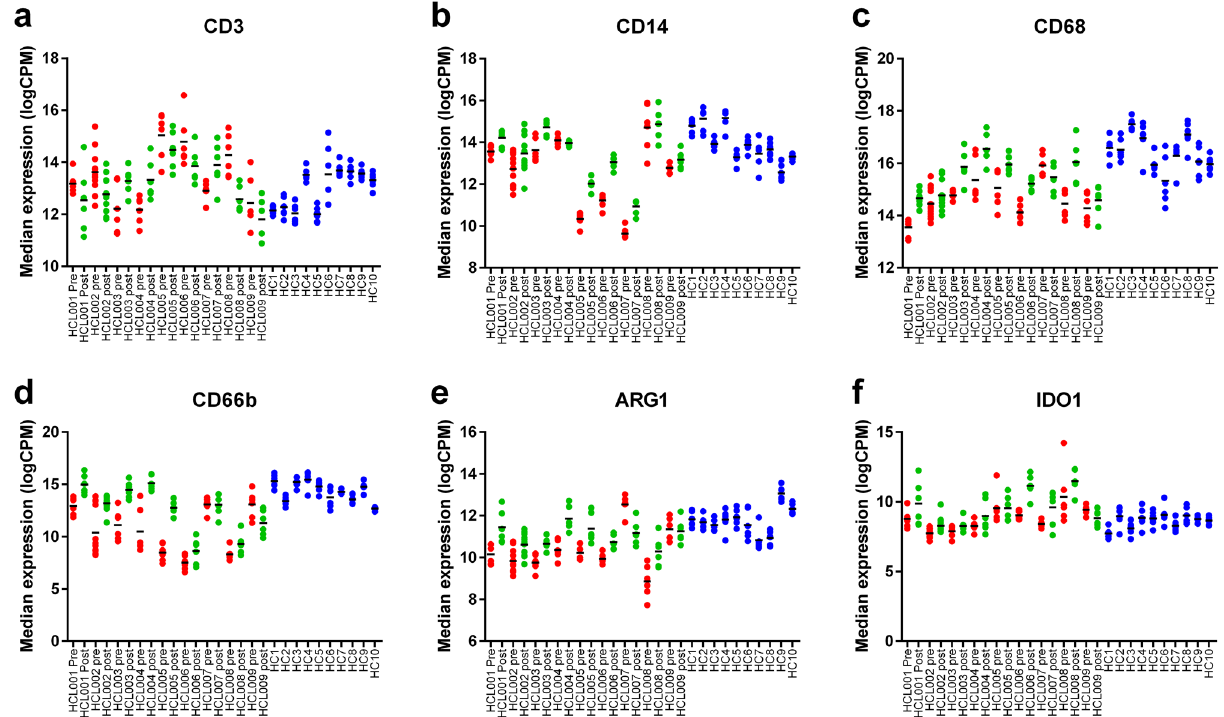
Figure 3. CDA treatment is associated with an increase in cells of monocytic lineages. Expression of immune cell markers pre- (red) and post-CDA (green) compared to control samples (blue). ( a ) CD3, ( b ) CD14, ( c ) CD68, ( d ) CD66b, ( e ) ARG1 and ( f )